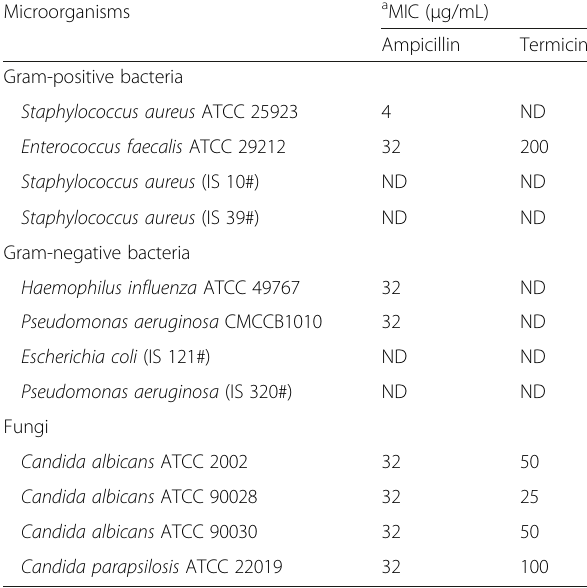
Table 1 The antimicrobial activity of Es-termicin Microorganisms a MIC ( μ g/mL)